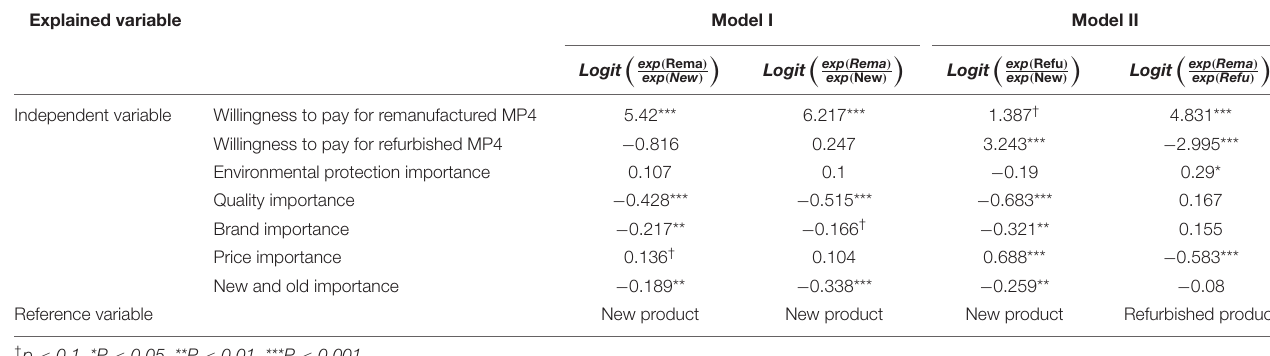
TABLE 7a | Logit regression result of Model I, II (MP4, hedonistic products). Explained variable